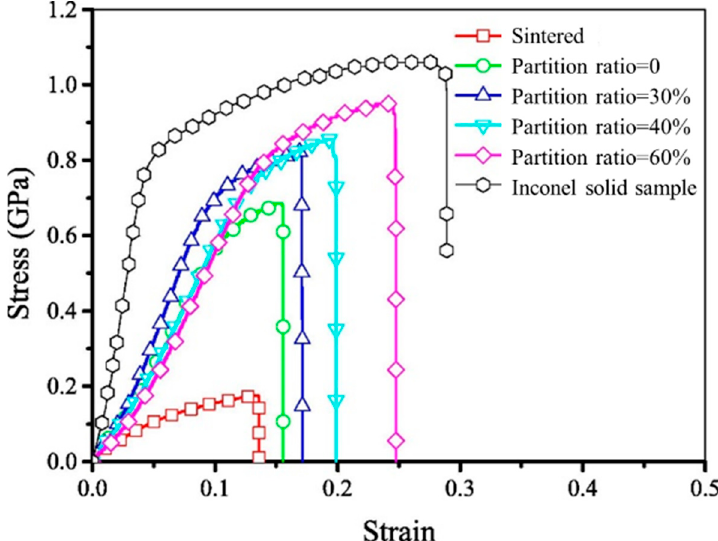
Figure 33. Tensile stress–strain curves of different Inconel porous plates. Adapted with permission from [126]. Copyright 2018 Elsevier.